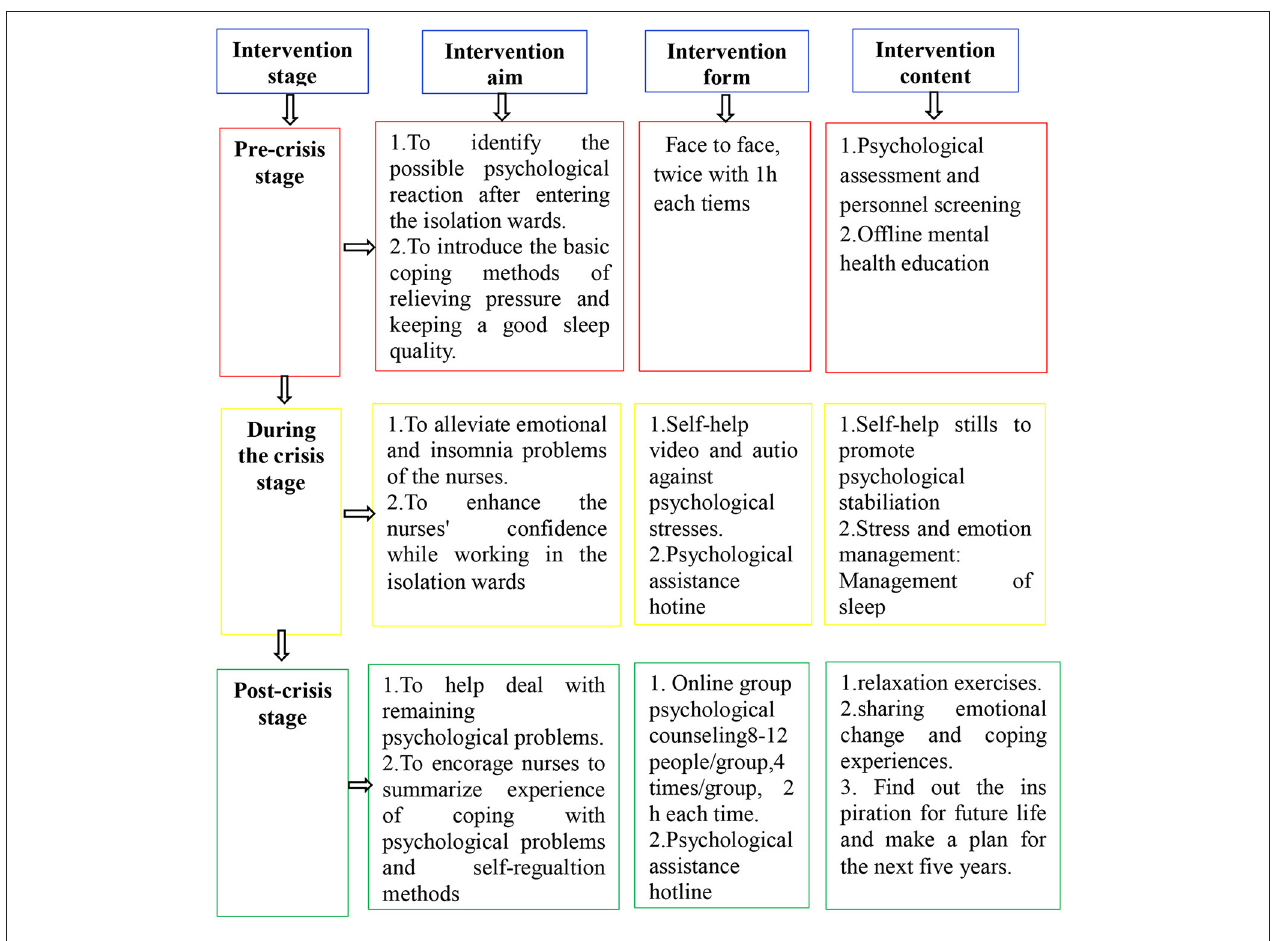
FIGURE 1 | A three-stage psychological crisis intervention